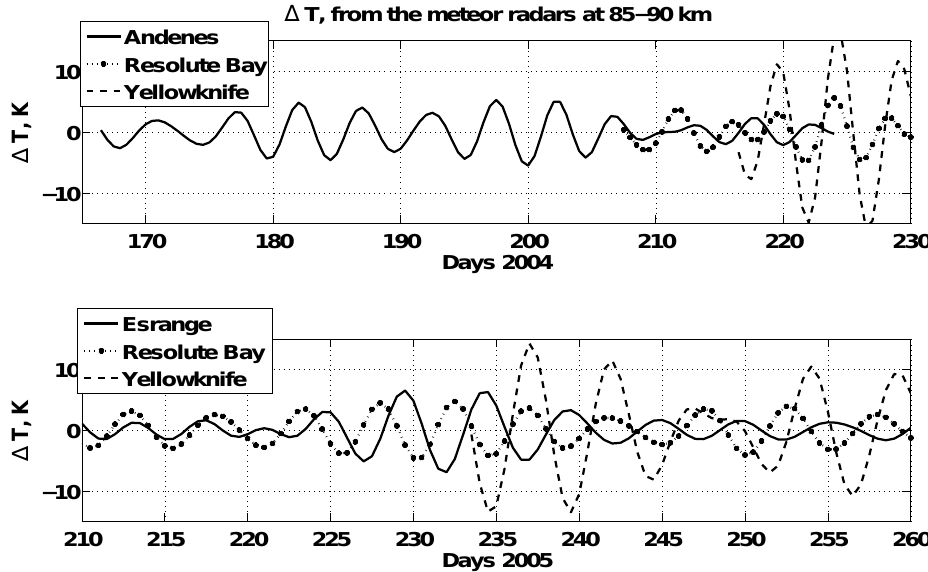
Fig. 4. 5-day wave perturbations obtained from ground-based radar measurements of temperature by meteor radars: Upper panel: for 14 June–11 August 2004. Solid line is from temperature data over Andenes (69 ◦ 17 0 N, 16 ◦ 00 0 E), at 90km; dashed line is from temperature data over Yellowknife, (62 ◦ 30 0 N, 114 ◦ 32 0 W) at 88km; dotted line is from temperature data over Resolute Bay (74 ◦ 30 0 N, 95 ◦ 00 0 W) at 87km. Lower panel: for 27 July–17 September 2005. Solid line is from temperature data over Esrange (67 ◦ 56 0 N, 21 ◦ 04 0 E), at 85km; dashed and dotted lines are from Yellowknife and Resolute Bay,